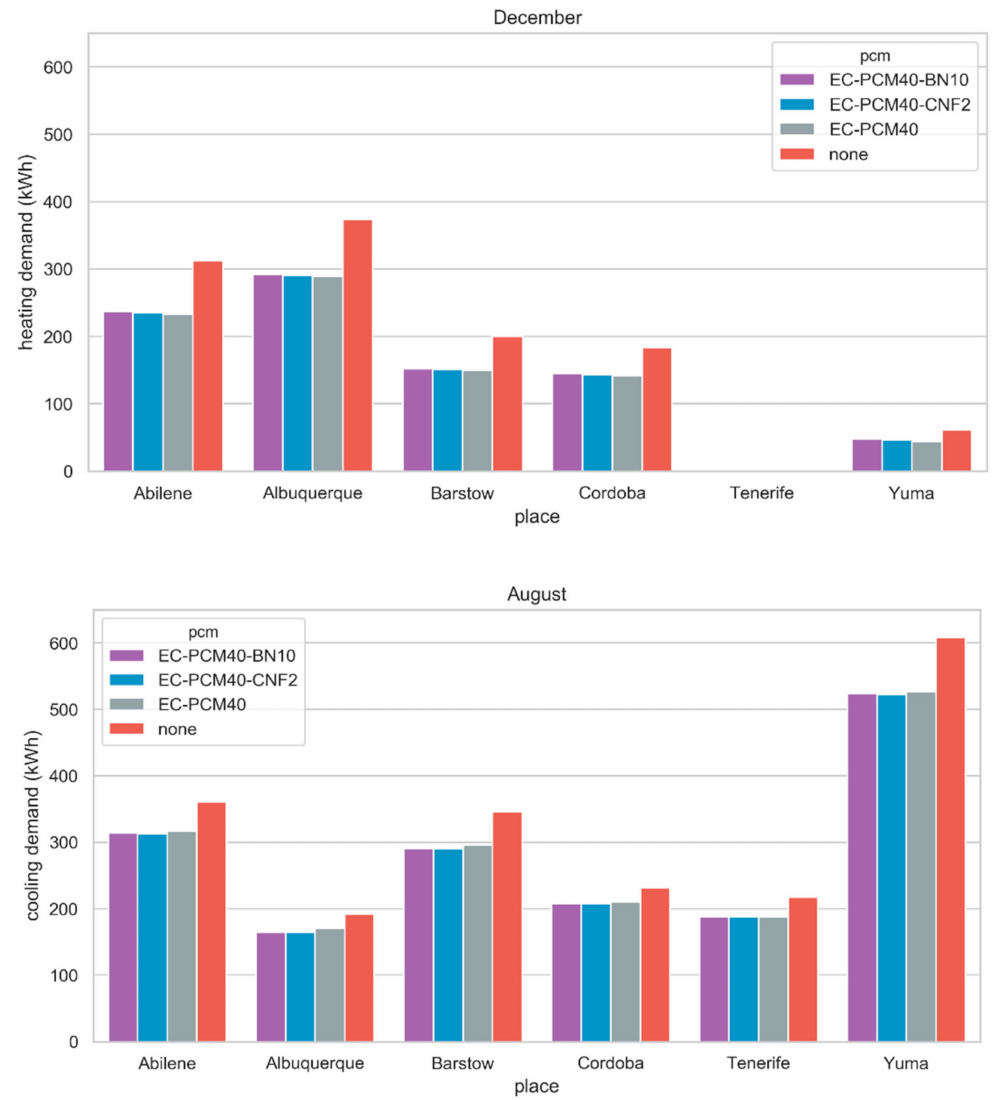
Figure 4. Heating and cooling demands for December and July for the six